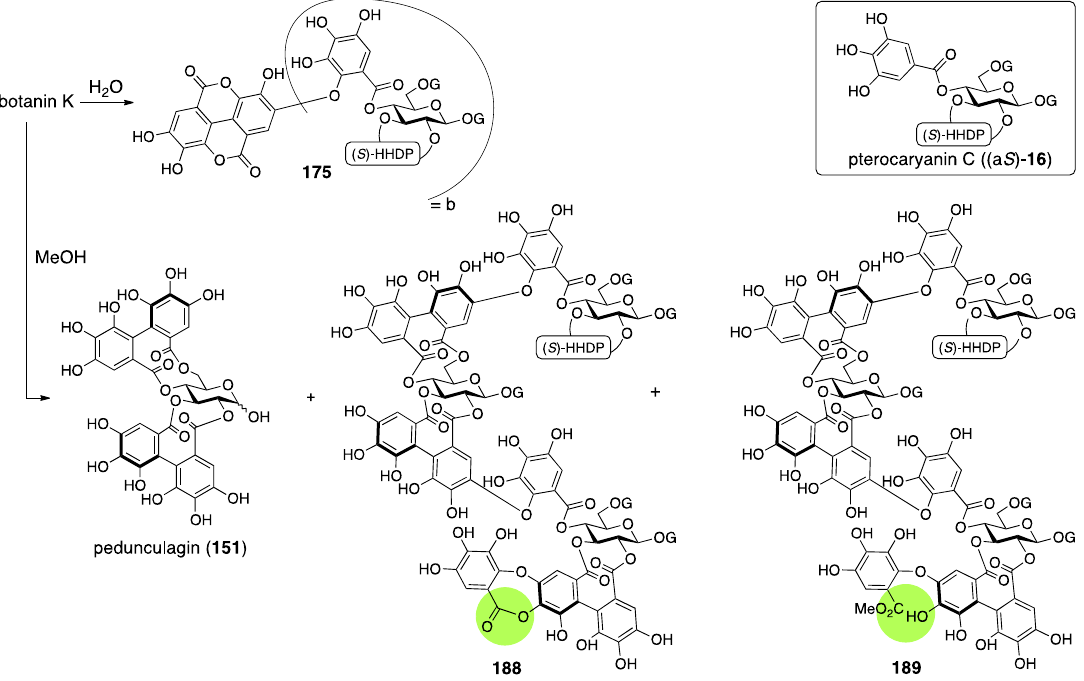
Figure 60. The information used for the revision to the latest structure of nobotanin K ( 173 ).